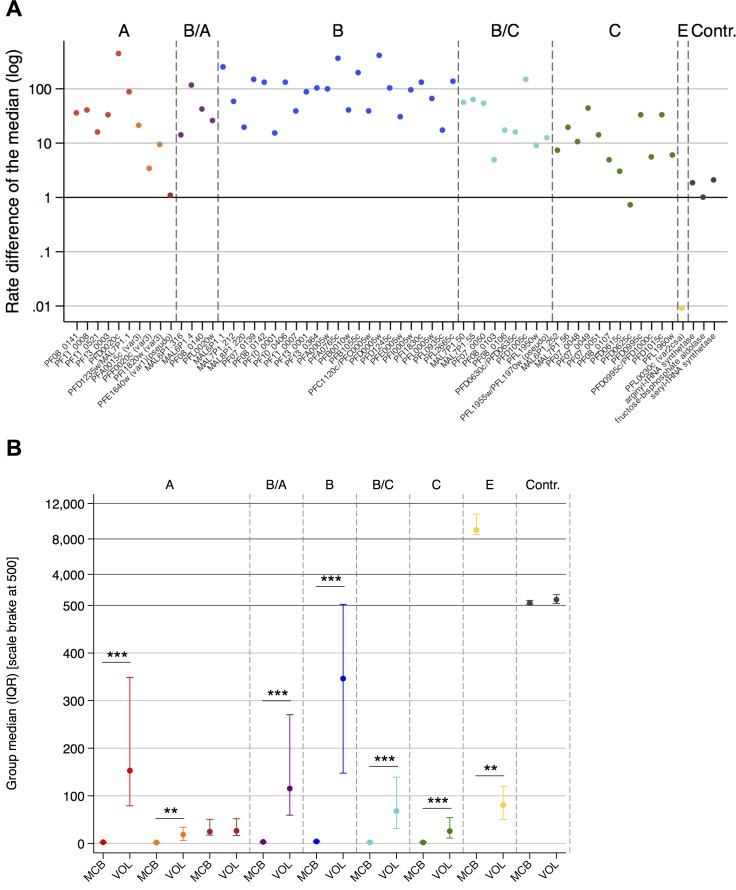
Modification of var transcription by mosquito transmission.(A) The rate difference of the median expression for each individual var variant and the housekeeping controls shows the overexpression of the entire var gene family in vivo with exception of the var2csa gene PFL0030c in comparison to the parental Master Cell Bank (MCB) parasite line. Each point reflects the median for the volunteer samples at the day of patent infection (n = 18) divided by the median observed for the parasite generations 6, 8 and 21 from two vials of the MCB cell line (n = 6). Housekeeping genes used as controls, var gene names and groups are indicated. (B) Differences in gene expression on group level between the pre-mosquito MCB parasite lines and parasites recovered from the infected volunteers (VOL) at the day of patent infection determined by thick blood smear are displayed as group median with interquartile range (IQR). Significant differences in distributions between MCB and VOL series were tested via a Wilcoxon rank-sum test using a Bonferroni corrected significance level. The graph contains a scale brake at the y-axis to account for the huge variability in the gene expressions. Group affiliations are indicated above the graph. Red (A), orange (A, subfamily var3), dark red (A, subfamily var1), purple (B/A), blue (B), turquoise (B/C), green (C) and yellow (E).